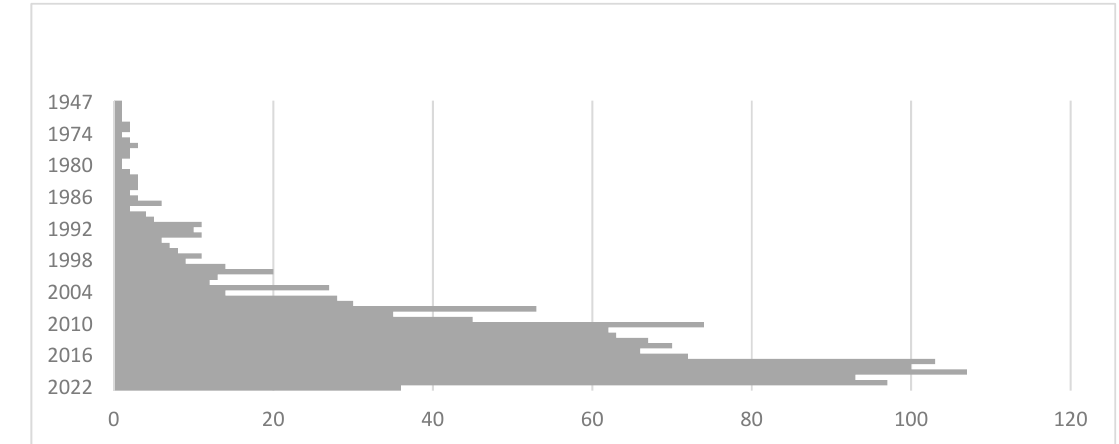
Figure 6. Number of publications in the Scopus. Source: created by the authors. According to the Scopus database, the most influential authors are Griffin, A., Chandy, R.K., Ford, E.W., Mazzucato, M., Prabhu, J.C., Sergeeva, N., Vossen, A. This differs from the results of the VosViewer network analysis where the most cited articles and linkages are created by Hauser J., Lin, H.J., West, J. A total of 238 works were clustered in 27 clusters and 316 links (see Figure 7).